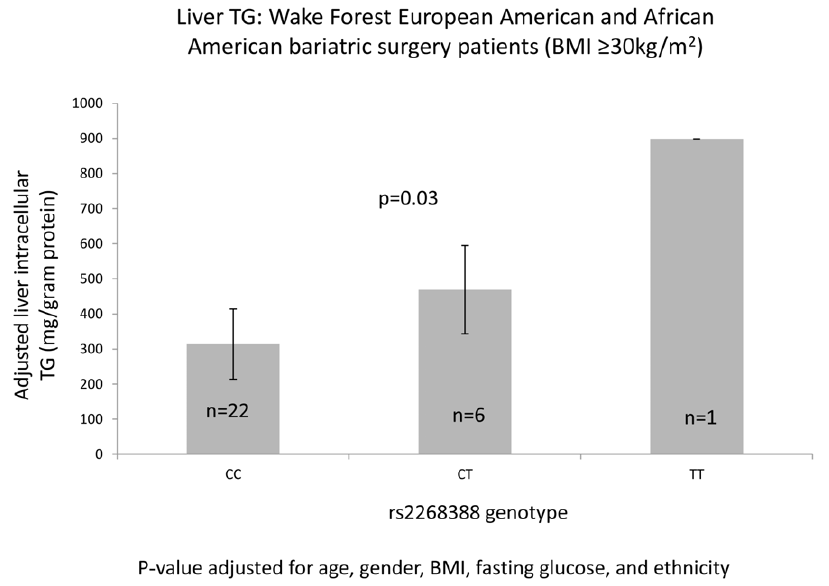
Figure 5. Liver cell triglyceride (TG) by rs2268388.